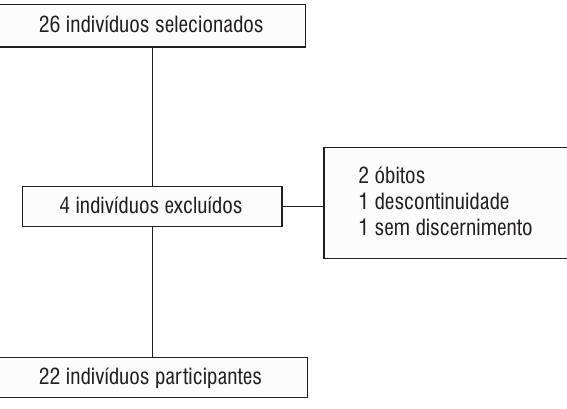
Figure 1 - Exclusion process of the selected subjects Among the patients, 19 (86.4%) were male and three (13.6%) were female, with a mean age of 58.86 (±9.41) years. Thirteen (59.1%) of the subjects an- swered that they used some kind of